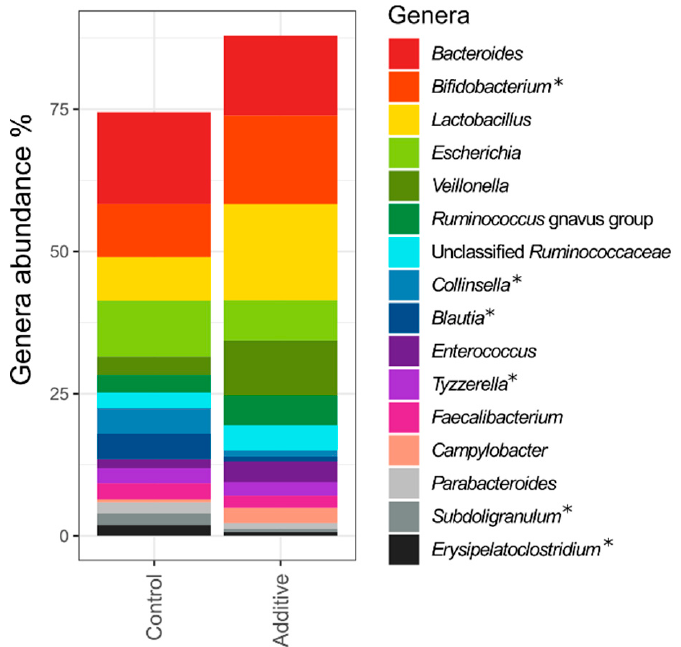
Figure 2. Relative abundance of the 16 most abundant genera found overall in control- or additive- diet lamb fecal samples. Asterisks point out those genera that showed significant differential abundance between control- and additive-diet lamb fecal samples, according to LEfSe analysis ( p < 0.05). β -diversity (di ff erences between samples based on their microbial community composition) was evaluated by Weighted UniFrac and represented as a Principal Coordinates Analysis (PCoA) in Figure 3. Di ff erences between both groups of lamb fecal samples can be observed, as they tended to cluster together according to the diet followed by each group of lambs.